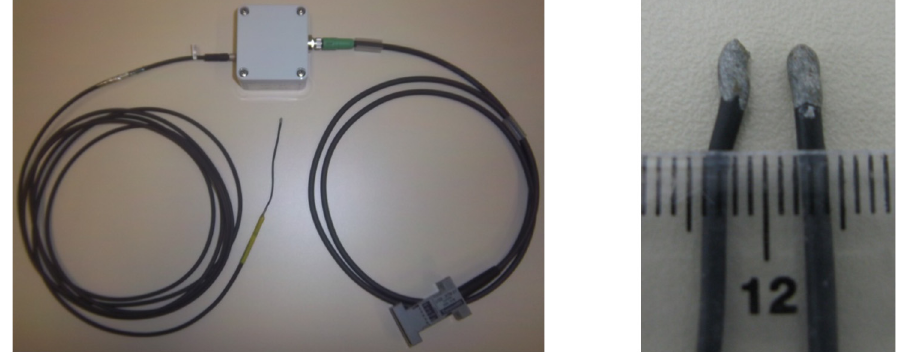
Fig. 1. Measuring system (left) and spherical sensors